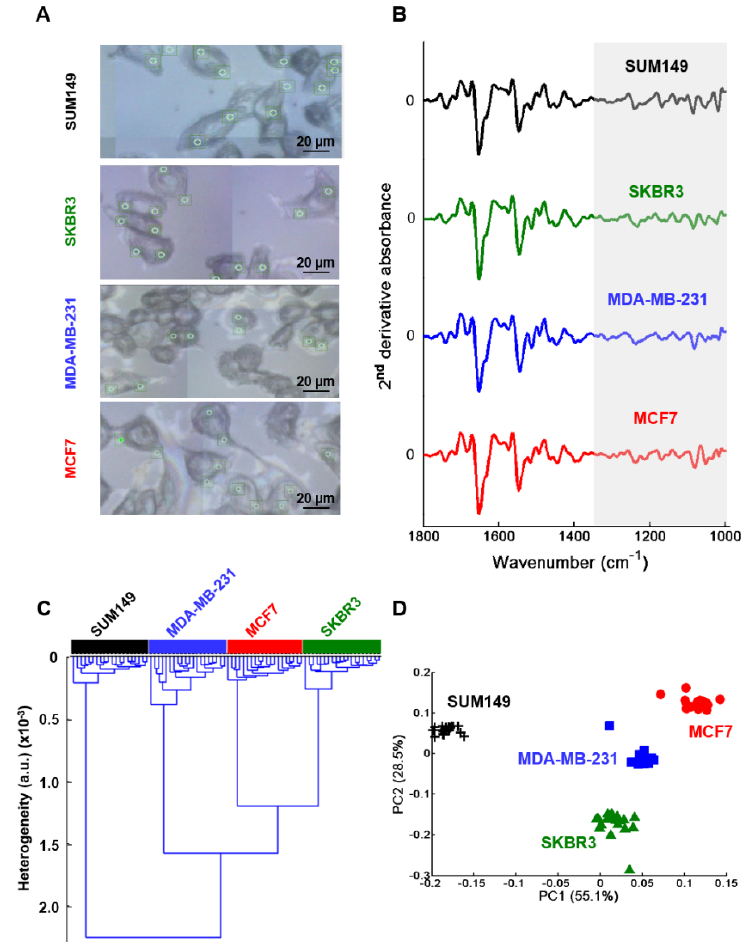
Figure 5. Synchrotron FTIR microspectroscopy of the cytoplasm of MCF7, MDA-MB-231, SKBR3 and SUM149 fixed single cells. ( A ) The white light image of each cell type showing the measurement points (green circle); ( B ) Normalized second derivative mean spectrum (n = 20) from the cytoplasm of the four cell lines. Spectra are offset for clarity; ( C ) HCA analysis and ( D ) PCA score plot of MCF7 (full red circles), MDA-MB-231 (full blue squares), SKBR3 (full green triangles) and SUM149 (black crosses). Both analyses were performed on normalized mean second derivative spectra using frequency range 1350–990 cm − 1 .